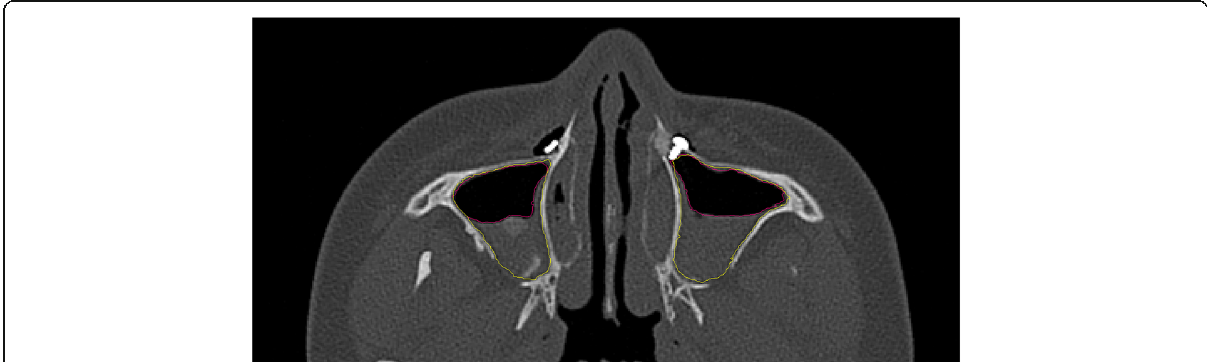
Fig. 2 Borders of the empty spaces (red) within the maxillary sinus (yellow) according to the white gray values were identified on all CT scans at the level of the maxillary